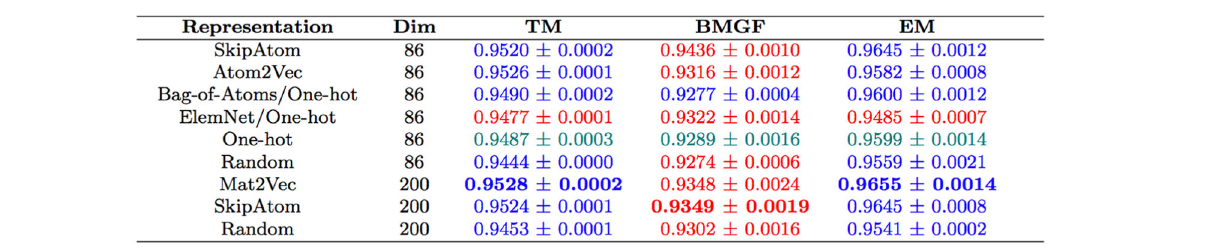
Table 4. Benchmark classi fi cation task results after two-repeated fi ve-fold strati fi ed cross-validation; mean best ROC-AUC on the test set after 100 epochs of training in each